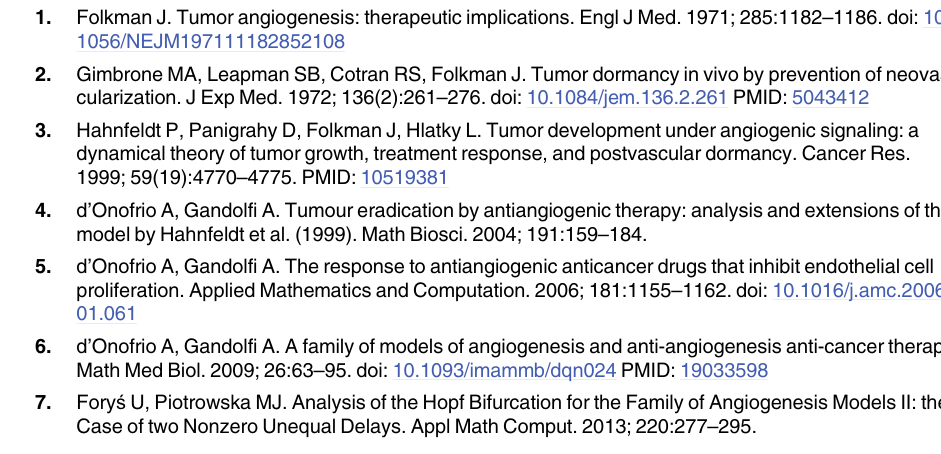
S1 Fig. Tumour cells populations diverges from macroscopic predictions. Histogram show- ing the probability per trajectory of having N (cid:3) tumour cells at different times. Results corre- spond with same parameters used in Fig 4 with 1000 Gillespie realisations. Populations around deterministic state (dark blue) jump over time to a state with less tumour cells (cyan), percent- ages indicate the probability to find a tumour in each state. S2 Fig. Tumour spontaneous extinction probability is determined during the first week. Histogram showing the probability per trajectory of having N (cid:3) tumour cells at different times. Results correspond with the same parameters used in Fig 11 with 2000 realisations. A fraction of the growing tumour population (dark blue) dies during the first week N = V = P = 0